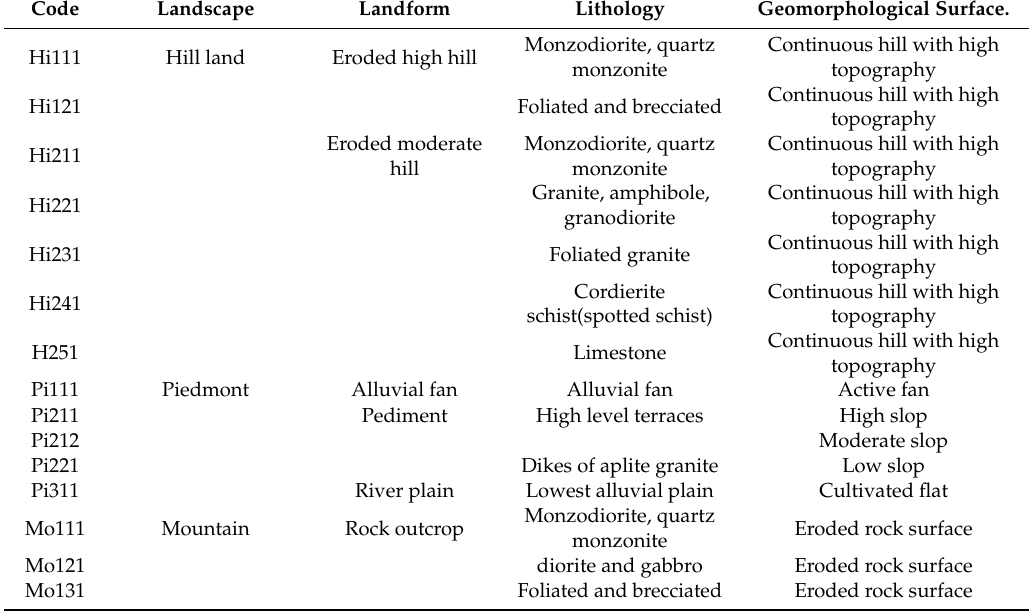
Table A1. Geomorphology map key and the major soil sub-groups, land index and current and potential future land suitability class per geomorphological